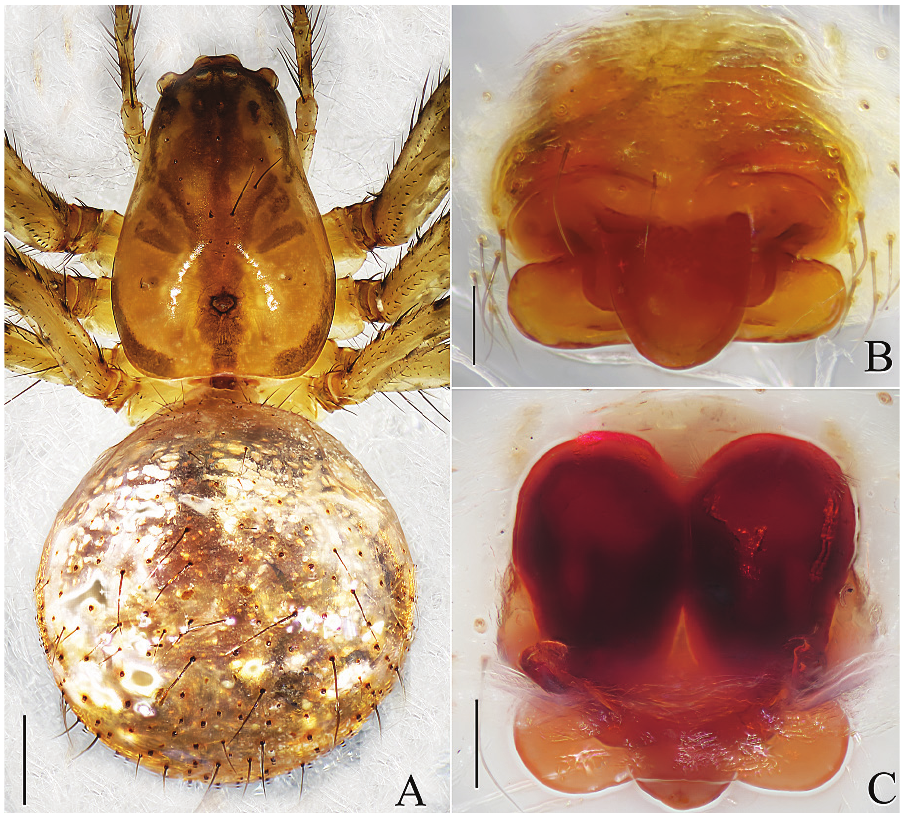
Figure 3. Mimetus echinatus Wang, 1900, from Shimen. A habitus, dorsal view B epigyne, ventral view C vulva, dorsal view. Scale bars: A , 1.0; B–C , 0.1. Redescription. Male. Carapace (Fig. 1A) bright yellow, long oval, widest at coxae II and III. Fovea circular, deep, its surrounding area reddish brown. Sternum light yellow, pear-shaped, the surrounding with seven gray circular patches, margin with long scopulae, median glabrous. AER slightly recurved, PER nearly straight, ALE and PLE contiguous. Chelicerae reddish brown, with 9 promarginal peg setae and 2 ret- romarginal teeth (Fig. 2C). Color of endites and labium similar. Legs spiniferous, femora with reddish brown patches. Dorsum of opisthosoma (Fig. 1A) suboval, light yellow-brown, with white patches on both sides, covered with long macrosetae. Venter grayish-white, with round white patches. macrosetae. Cymbium wedge, length/width ratio about 2/1, tip with several robust macro-setae Paracymbium distinct, distal black and strongly sclerotized. Distal divi- sion of the bulb rolls up as sulciform to protect embolus and serves as a functional con- ducter. Embolus relatively slender, distal division reaches the position of 2:00 o’clock approximately with a membrane covering its proximal area in prolateral